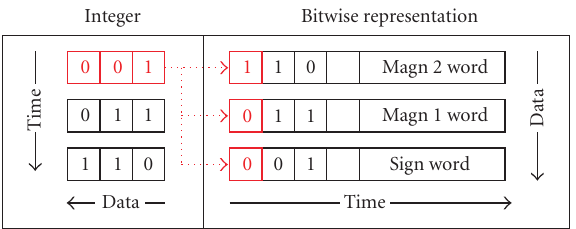
Figure 3: 3-bit integer versus bitwise data